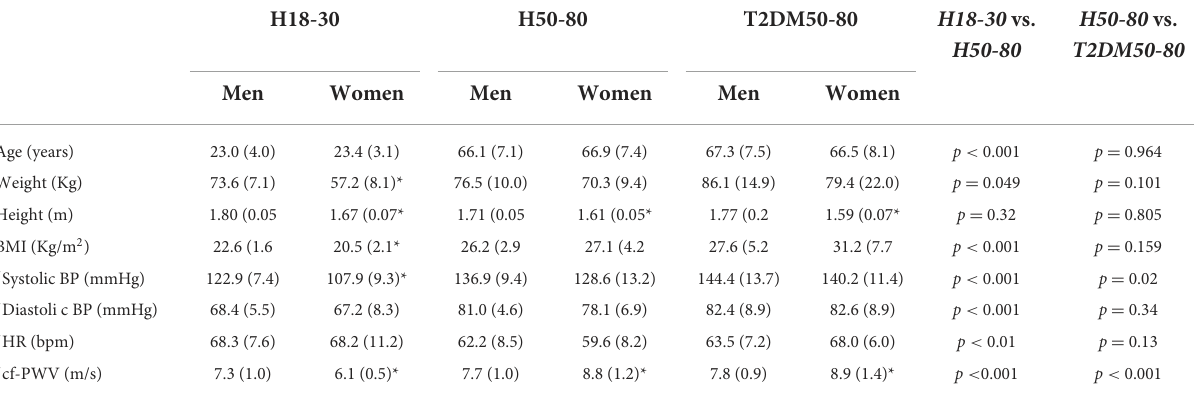
TABLE 1 Characteristics of the subjects ( n = 30), sex balanced within each